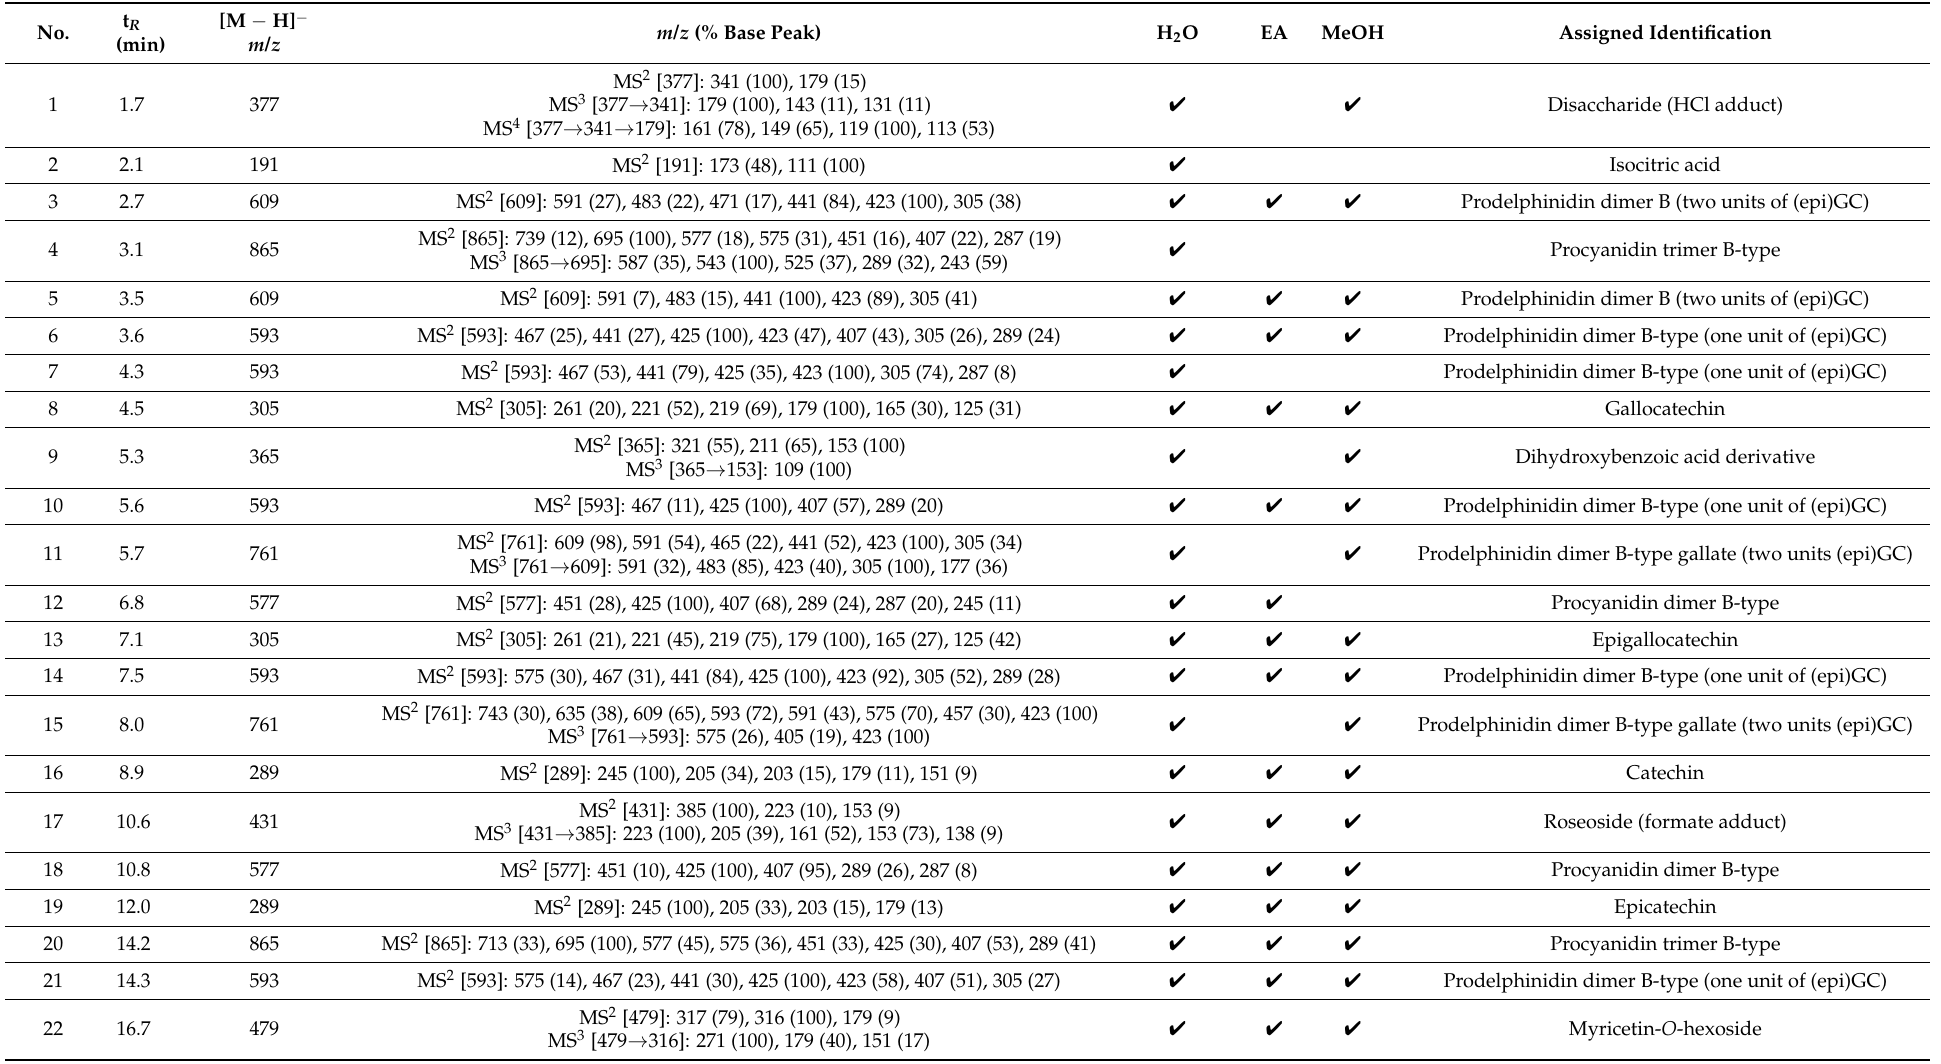
Table 2. Characterization of the compounds found in the analyzed extracts of Tambourissa peltata